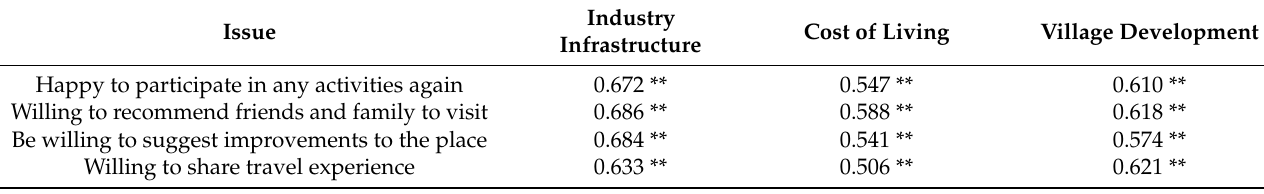
Table 7. Correlation analysis of the economic impact and re-tourism